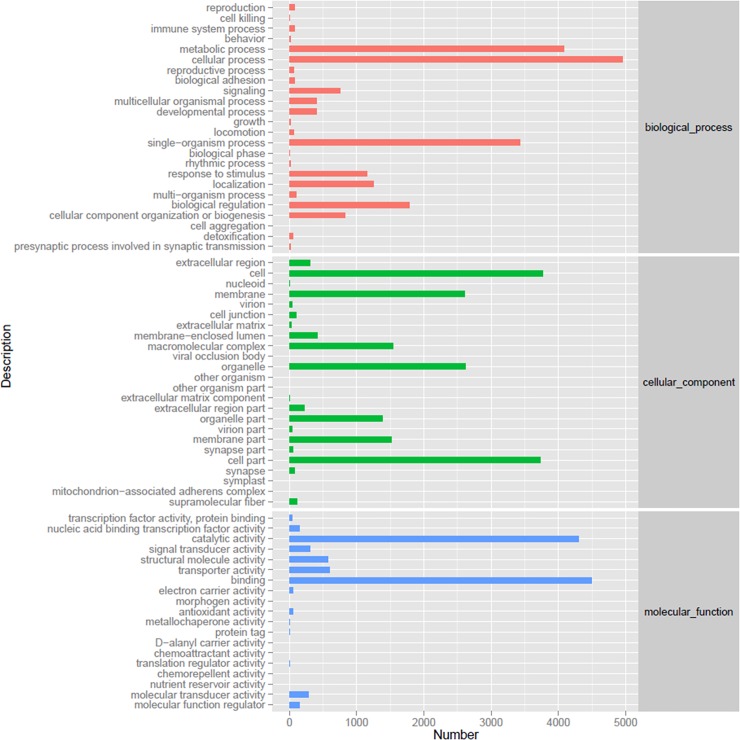
Gene Ontology (GO) categorization for assembled unigenes.